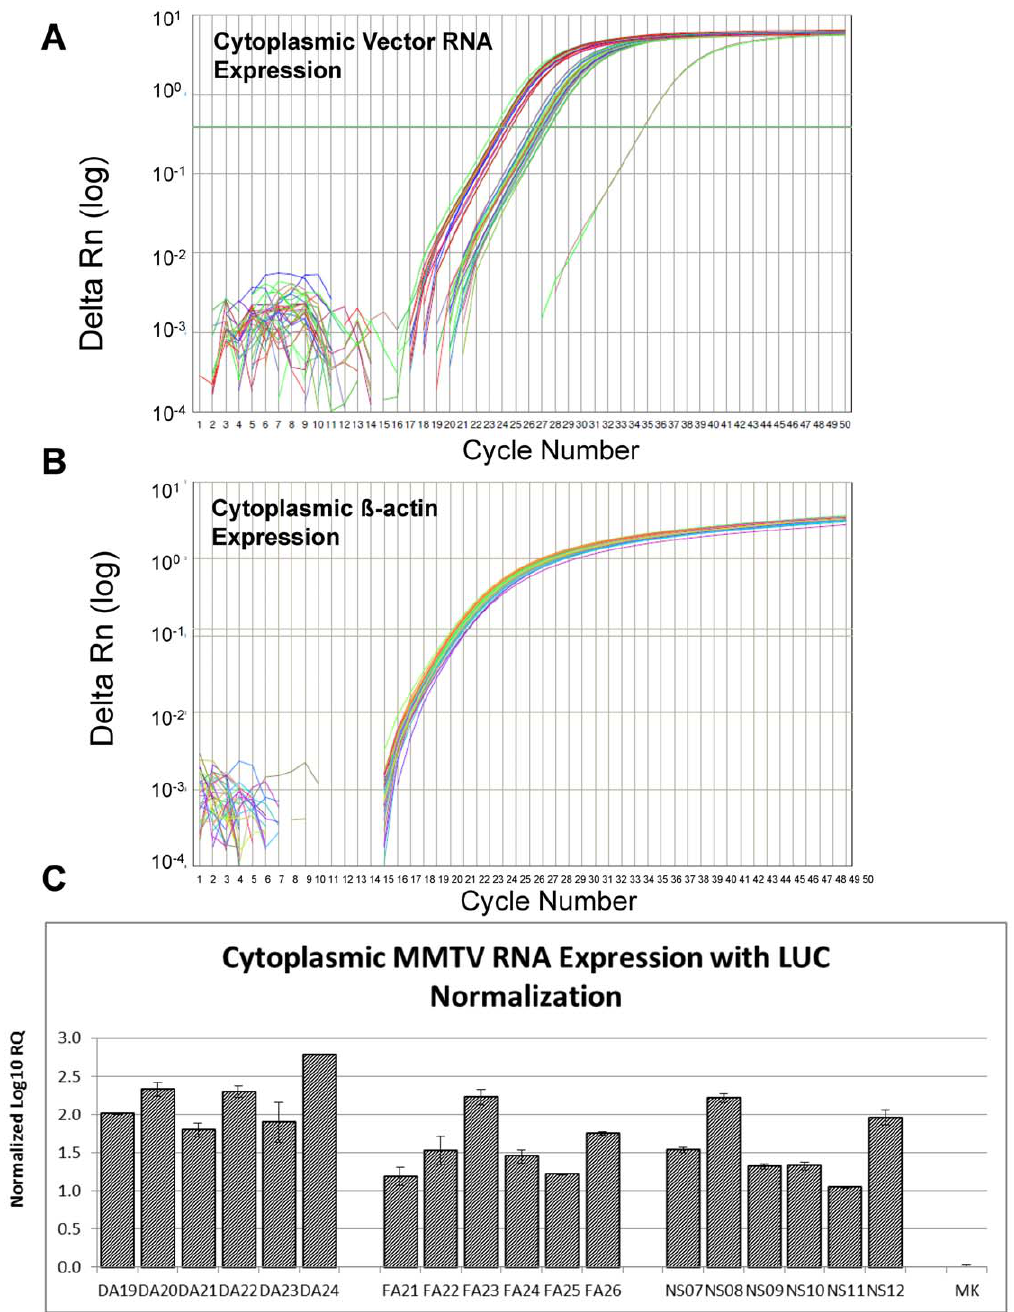
Figure 4. Relative expression of transfer vector RNAs within the transfected cells. Real time PCR analysis of ( A ) cytoplasmic transfer vector RNAs and ( B ) cytoplasmic b -actin RNA expression expressed as log D Rn verses cycle number. D Rn is the target gene-specific fluorescence signal (FAM for MMTV-specific and VIC for ß-actin-specific sequences) normalized to the signal for the internal passive control, ROX (Normalized Reporter or Rn) from which the baseline target fluorescence has been subtracted ( D Rn=Normalized Reporter (Rn) - baseline). ( C ) Relative cytoplasmic transfer vector RNA expression in 293T cells after normalization with b -actin and luciferase expression. MK, Mock, transfected cultures with packaging construct, JA10 + the VSV-G-Env expression plasmid, MD.G + luciferase-expression vector, pGL3 except the transfer vector. RQ, Relative Quantification in log 10 units. The primers for detecting the transfer vectors were designed within the U5 region of the MMTV LTR, a region common to all transfer vector RNAs. Each sample was tested in duplicates with MMTV- and b -actin-specific probes and primers as described in Materials and Methods.